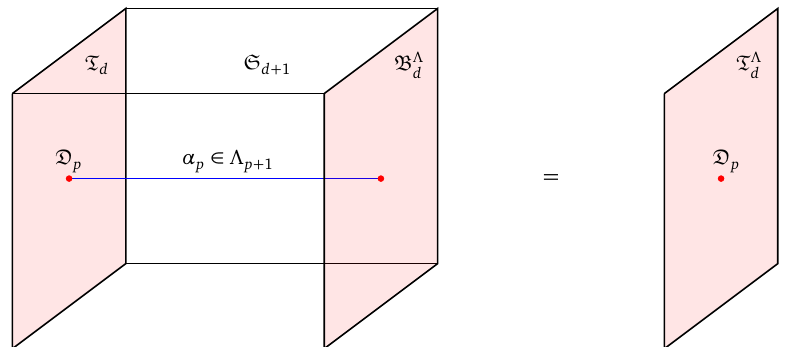
Figure 4: A defect D α ∈ Λ of the TQFT S p p + 1 α can end on the topological boundary B Λ p